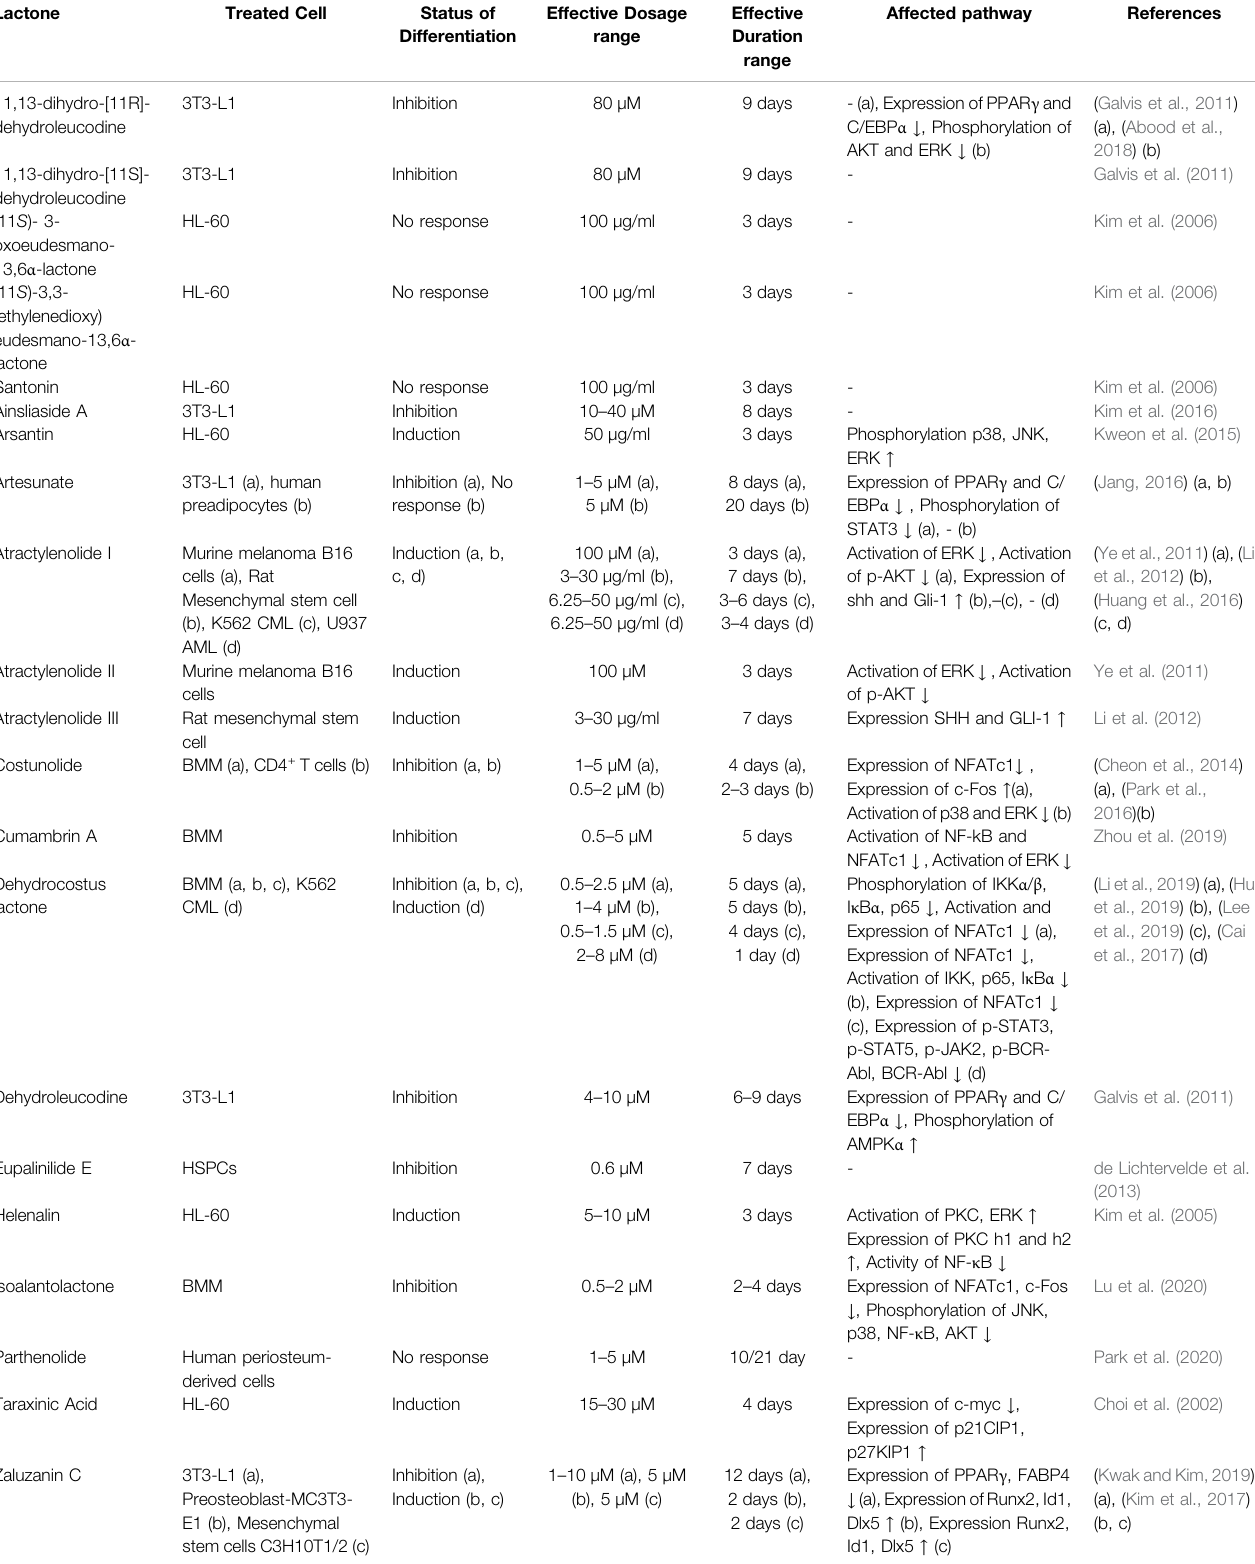
TABLE 1 | Sesquiterpene lactones and their